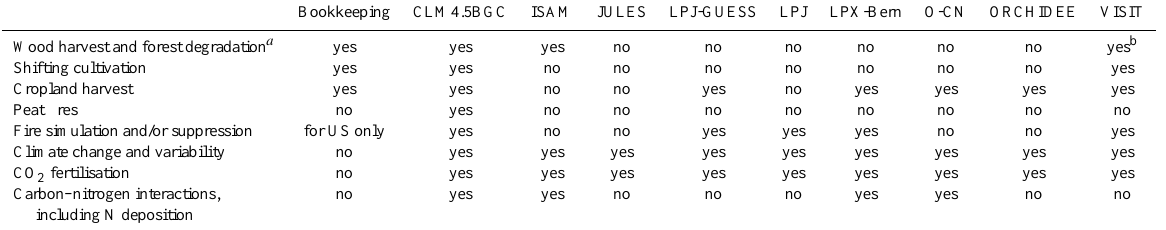
Table 5. Comparison of the processes included in the E LUC of the global carbon budget and the DGVMs. See Table 6 for model references. All models include deforestation and forest regrowth after abandonment of agriculture (or from afforestation activities on agricultural